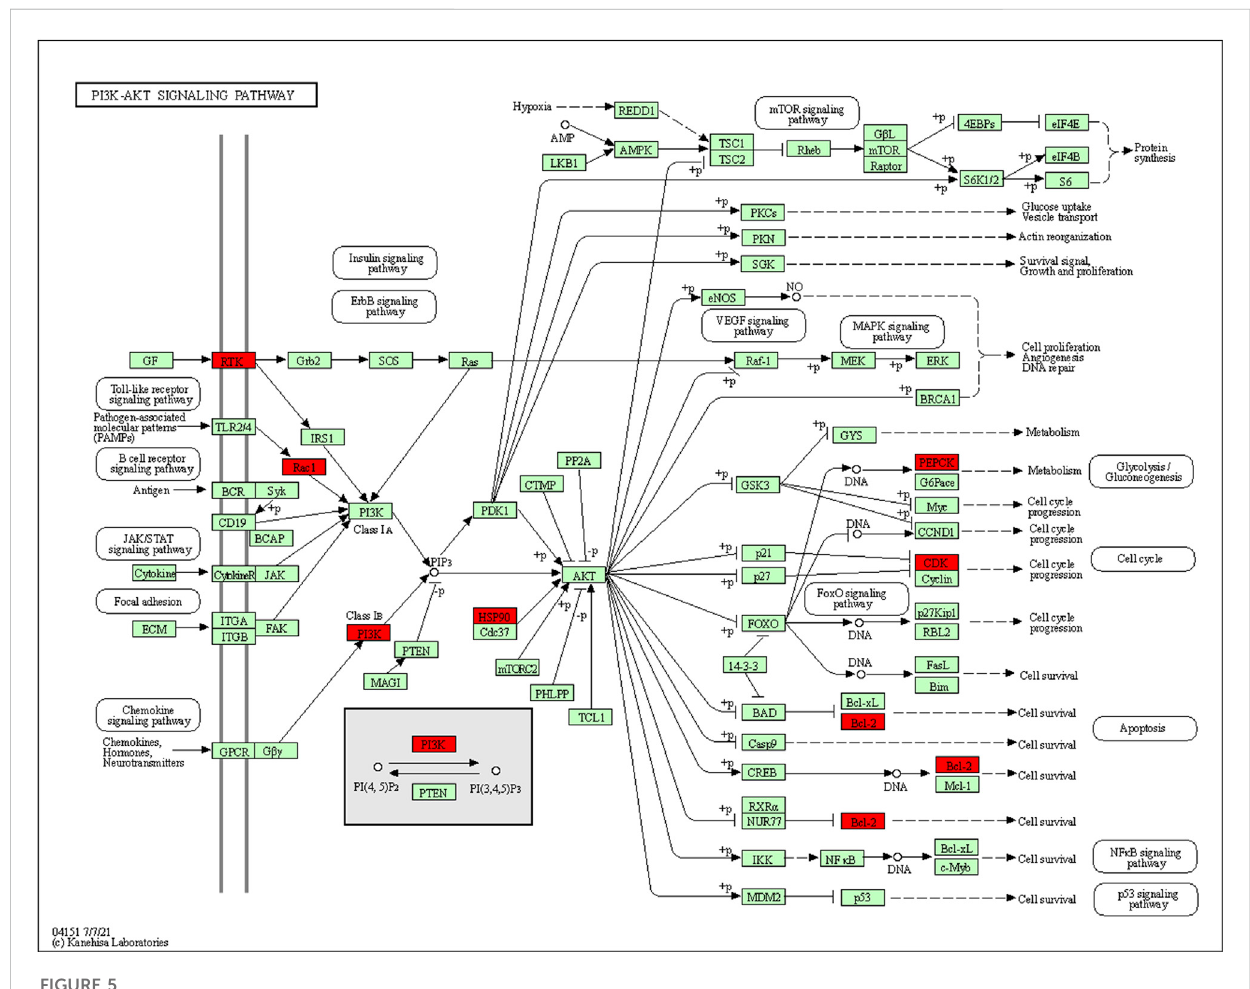
FIGURE 5 PI3K-Akt signaling pathway (red marks represent potential targets for curcumin intervention).